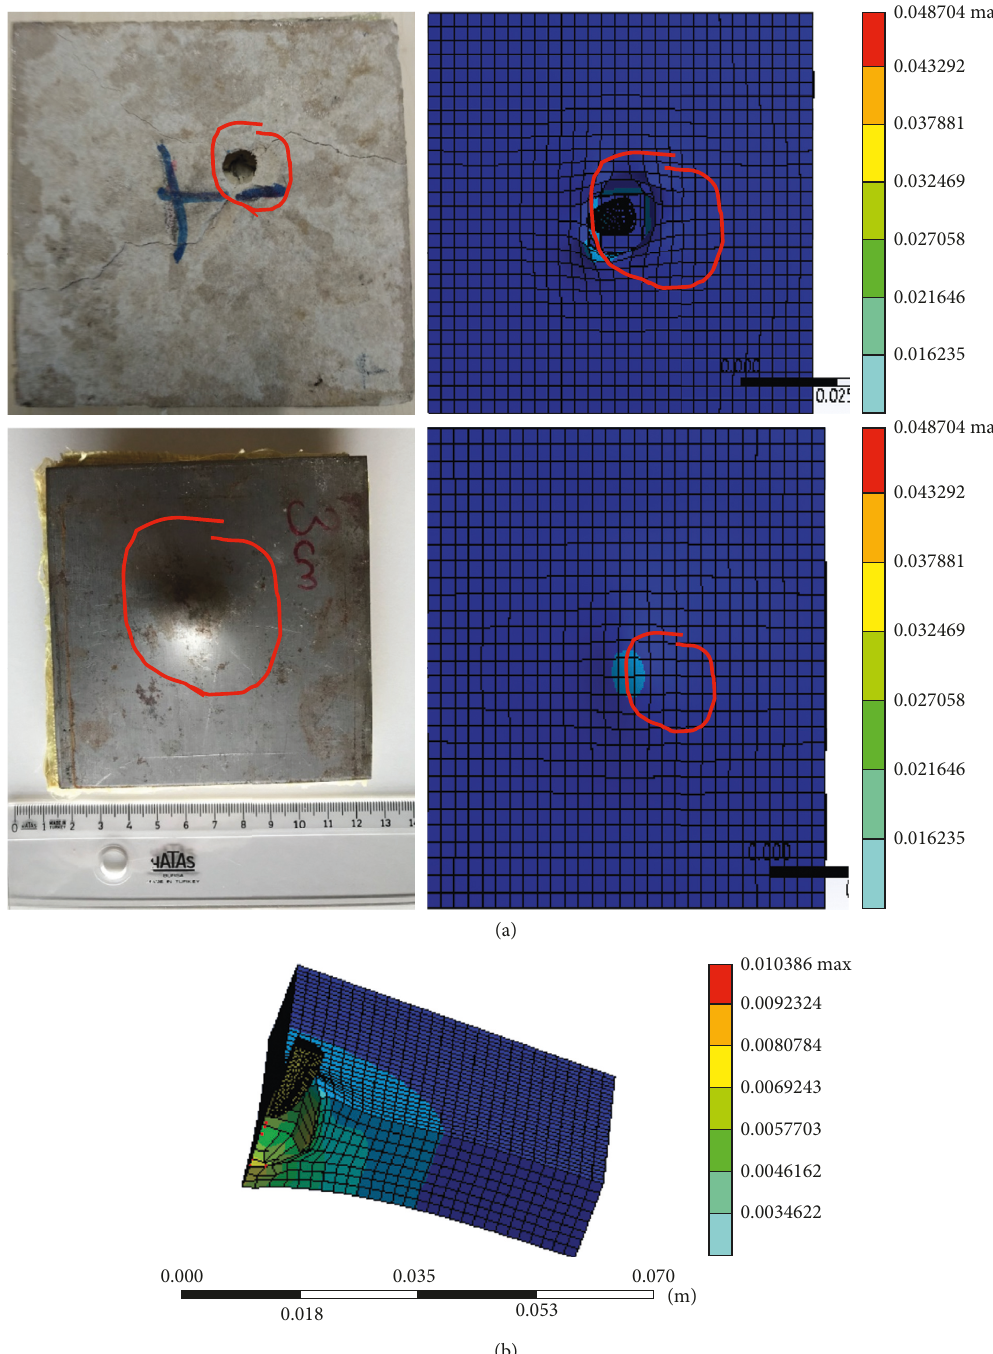
Figure 7: (a) Front and the back side of deformation of sample 1. (b) Total deformation of sample 1 as shown in experimental and simulation conditions (3D cross section of sample 1